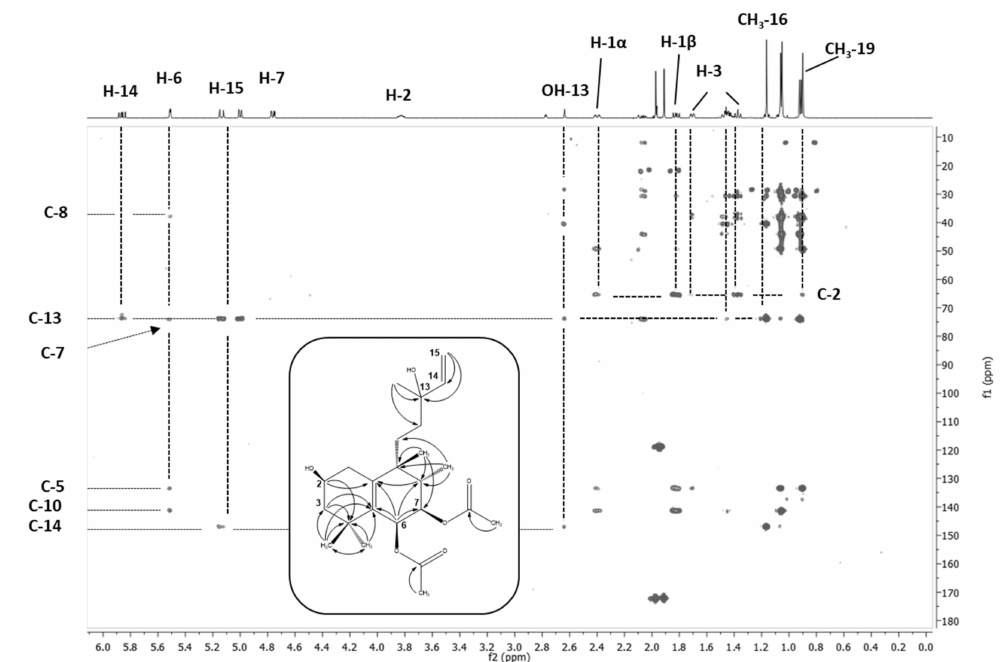
Figure 4. HPLC-SPE-NMR-based long-range shift correlation (HMBC) NMR spectrum of M16 (2 β -OH VD) recorded in CD 3 CN at 300K. Experimental conditions: pulse program hmbcgplpndqf; 2K data points in the 1 H domain, 256 increments in the 13 C domain, zero filled to 1K. Recording of 96 transients per increment, acquisition time 11.5 h. The C-H correlation signals not only allowed for connection of the individual proton networks of the H-H correlation pattern derivable substructures, but also for unequivocal placement t of metabolic oxidation at the carbon position